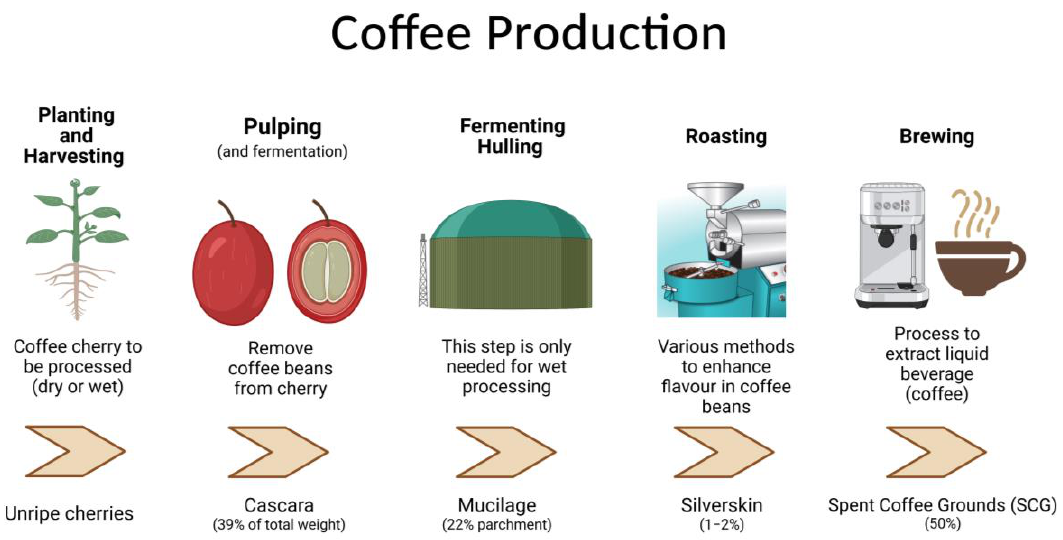
Figure 1. Coffee production generating waste. Data sourced from [14,17,18].